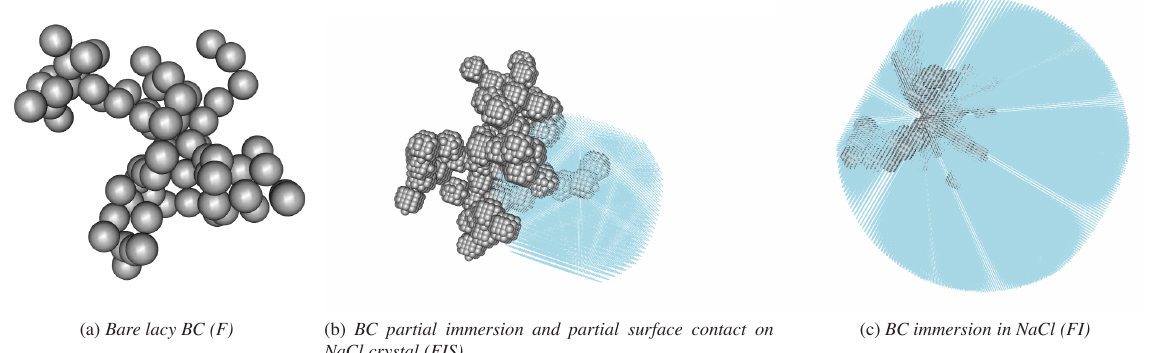
Fig. 5: Visual representation of modeled internal mixtures of lacy BC aggregates and NaCl. (a) Case F is a bare lacy BC aggregate. (b) Case FIS shows a BC partial immersion and partial surface contact on NaCl crystal, while (c) case FI is a total inclusion of BC (lighter grey) in salt particle (light blue). The points in light blue are the dipoles representing NaCl, while the circle in light grey represent the dipole position for BC. The dense number of dipoles fi nely characterizes the morphology of NaCl and of the BC aggregate.